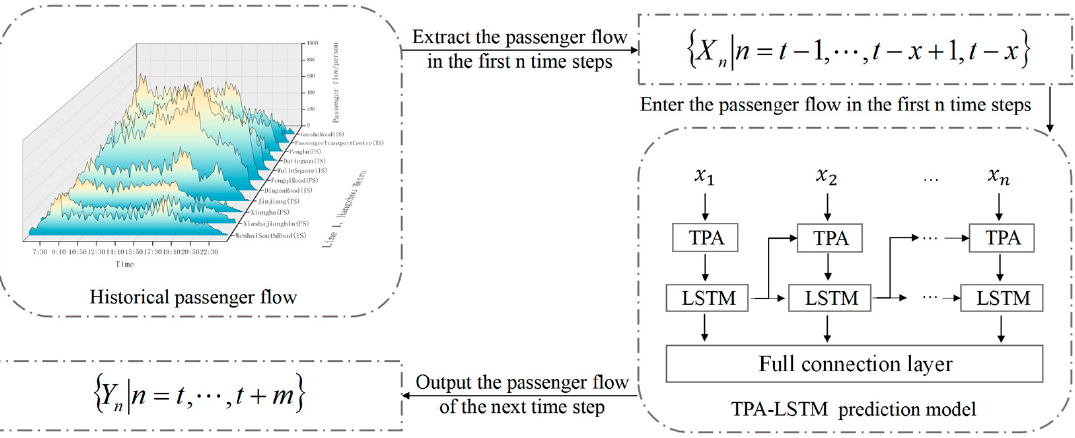
Figure 7. Data entry and forecasting.